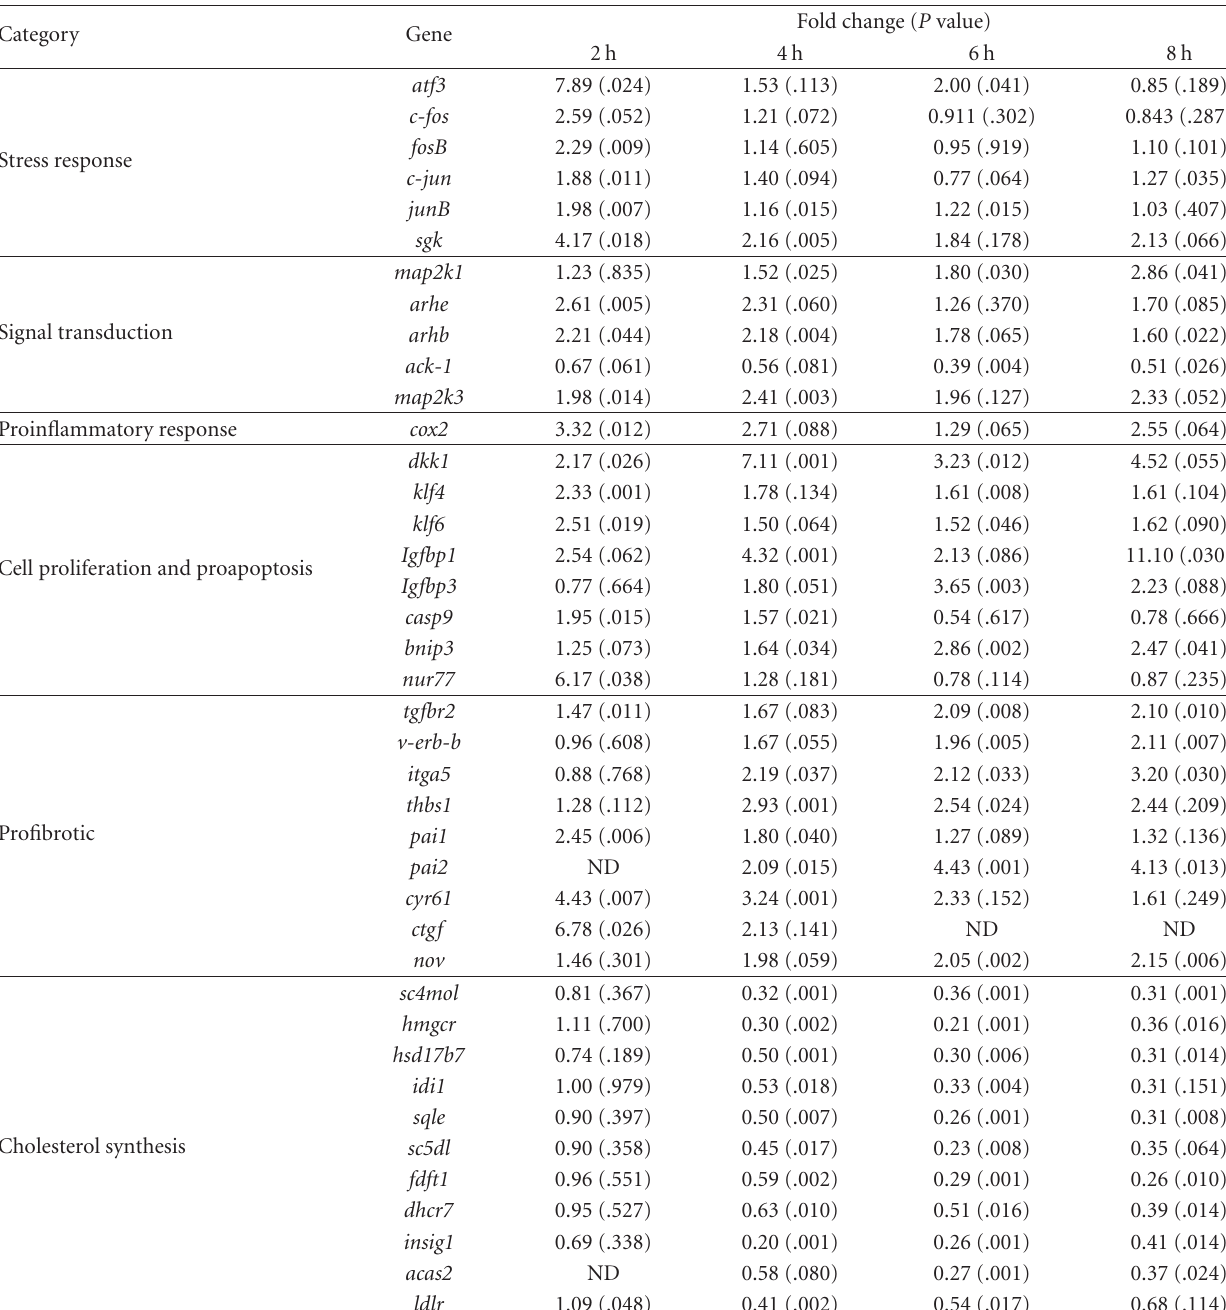
Table 2: Microarray analysis of gene expression changes in infected HEp-2 cell